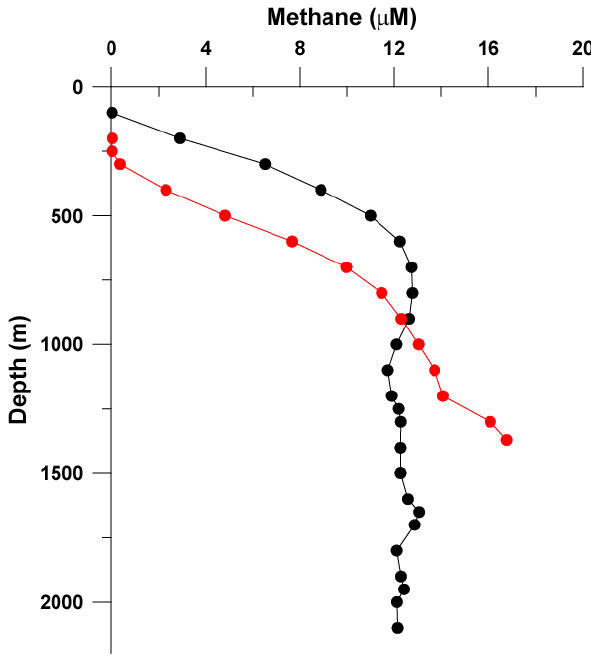
Fig. 11. Typical vertical profiles of CH 4 in the Black Sea (black symbols and curve) and the Cariaco Basin (red symbols and curve). Data are from Kessler et al. (2005, 2006a,